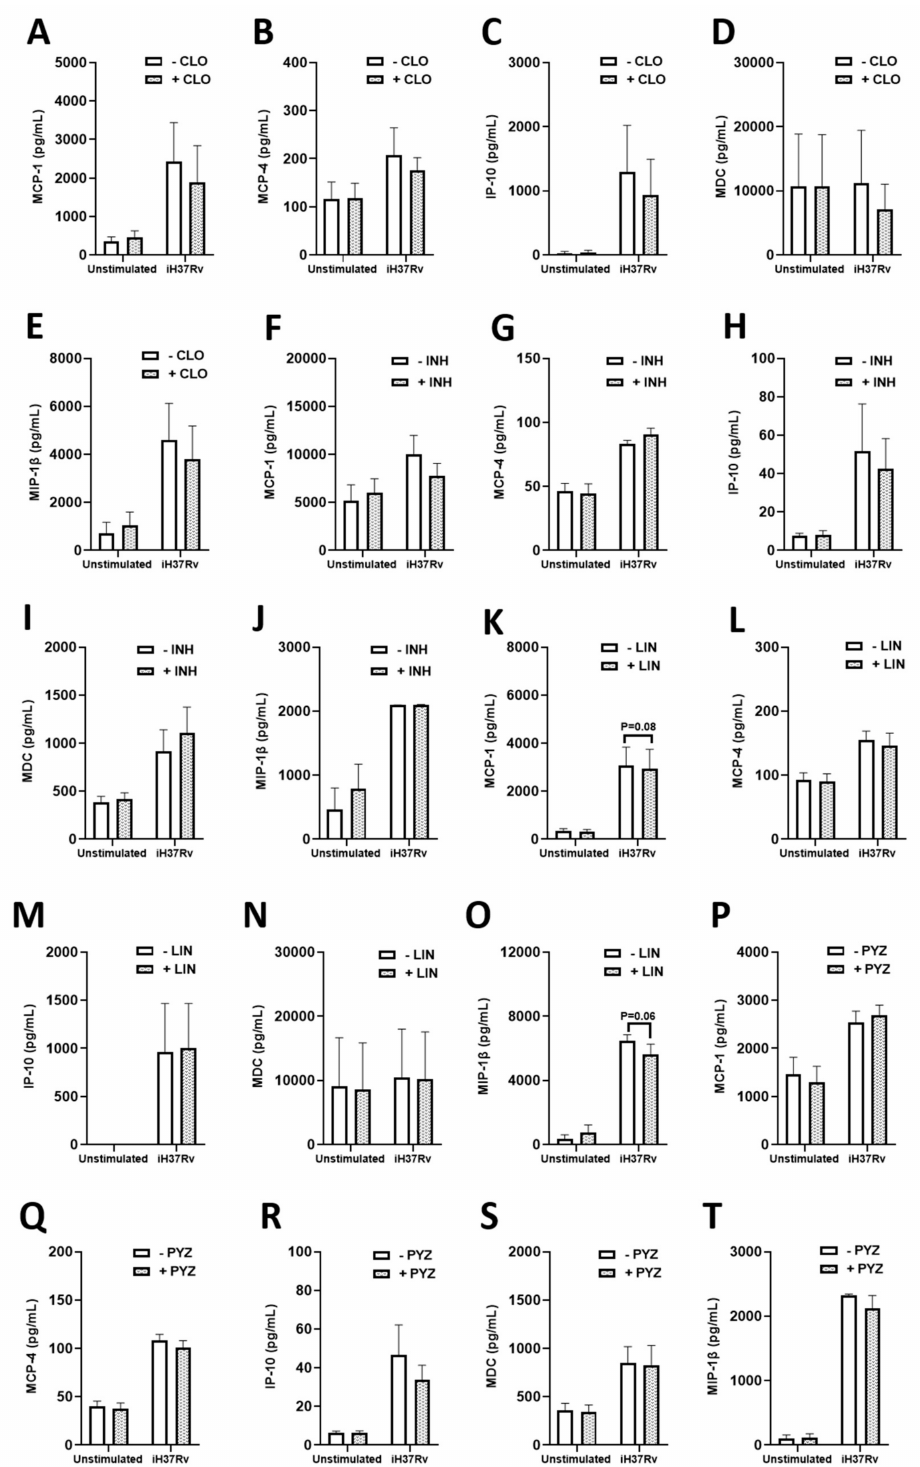
Figure 7. Assessing the effect of clofazimine, isoniazid, linezolid and pyrazinamide on protein levels of MCP-1, MCP-4, IP-10, MDC and MIP-1 β in hMDMs stimulated with iH37Rv-Mtb. hMDMs, differentiated from PBMCs isolated from healthy blood donors, were stimulated with iH37Rv-Mtb for three hours, washed to remove unphagocytosed Mtb, and were treated with clofazimine (2 µ g/mL), isoniazid (1 µ g/mL), linezolid (15 µ g/mL) or pyrazinamide (2 µ g/mL). At 24 h post stimulation, protein levels of MCP-1 ( A , F , K and P ), MCP-4 ( B , G , L and Q ), IP-10 ( C , H , M and R ), MDC ( D , I , N and S ) and MIP-1 β ( E , J , O and T ) were quantified using Meso Scale Discovery Multi-Array technology. Bars denote mean ± SEM. * p < 0.05 (Two-way repeated measures ANOVA tests with Š í d á k’s multiple comparisons